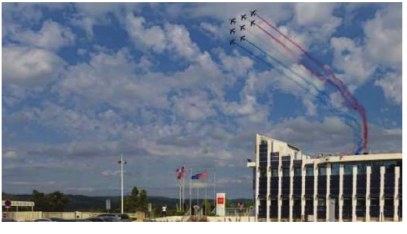
Fig. 1. CEA Cadarache center.